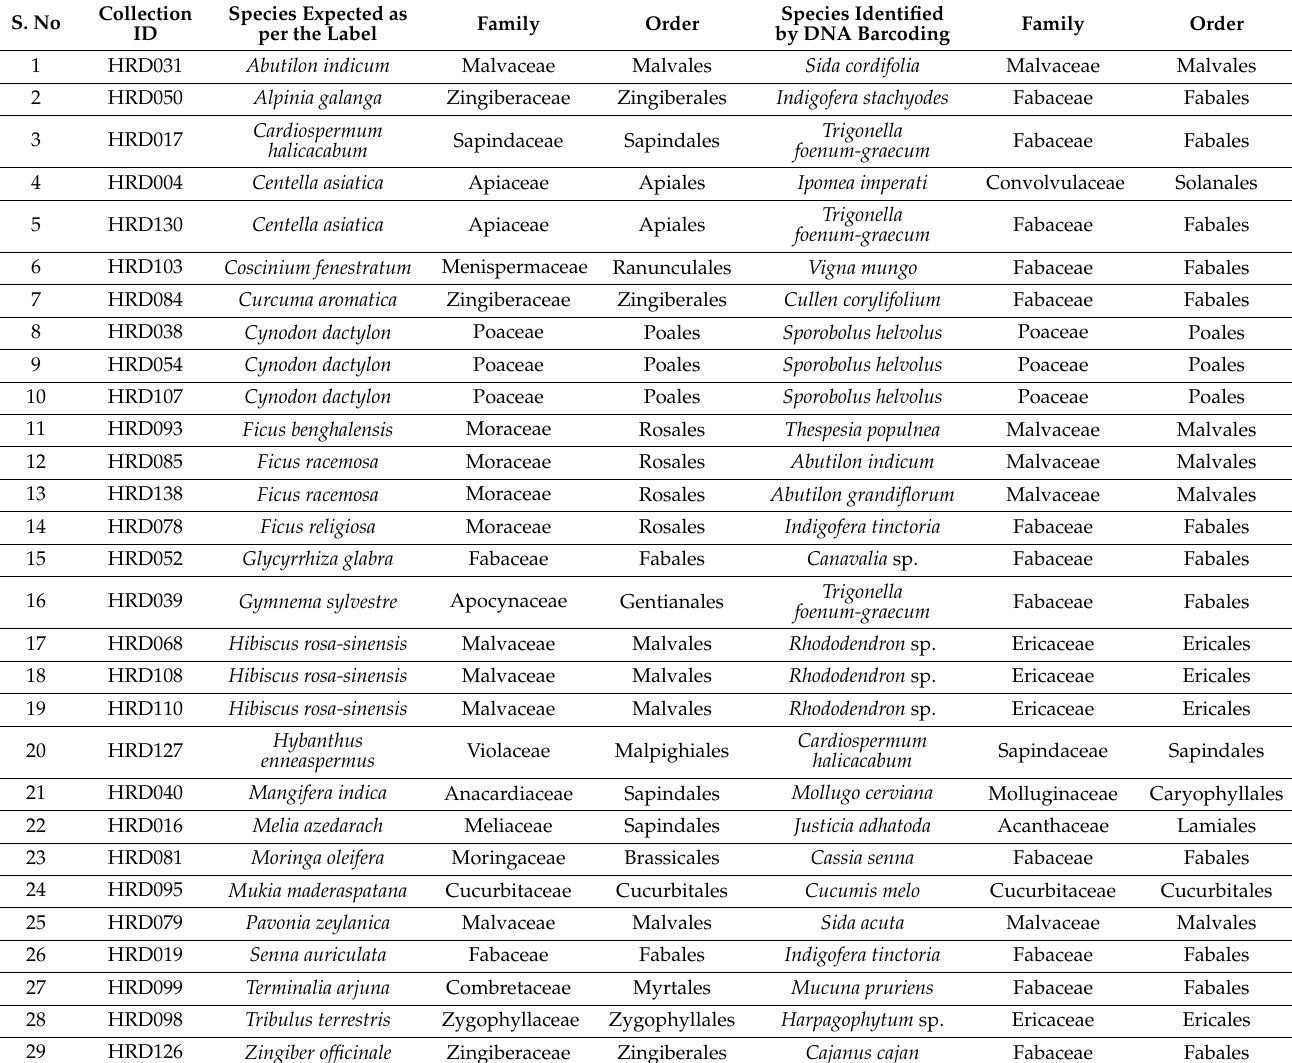
Table 1. Non-authentic single-drug powder samples in which authentic species was entirely sub- stituted with adulterant species. Taxonomic affiliations of the authentic and substituted species are provided for